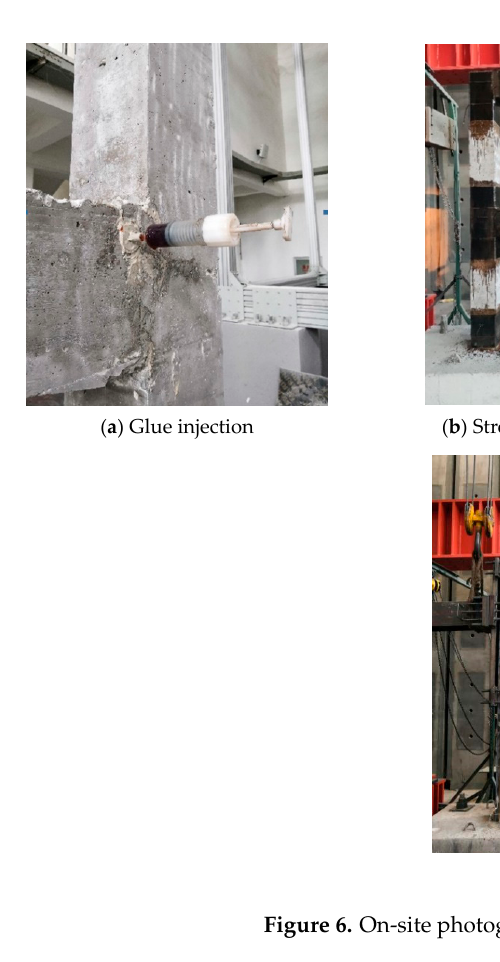
Figure 7. Layout of strain gauge.